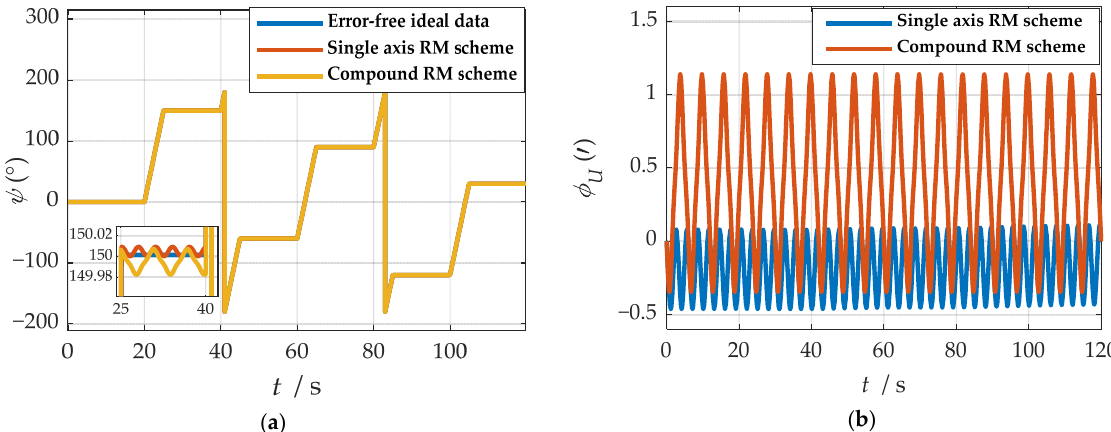
Figure 14. The navigation results comparison of the rotation scheme: ( a ) comparison of calculation results of pitch angle; ( b ) comparison of calculation results of up misalignment